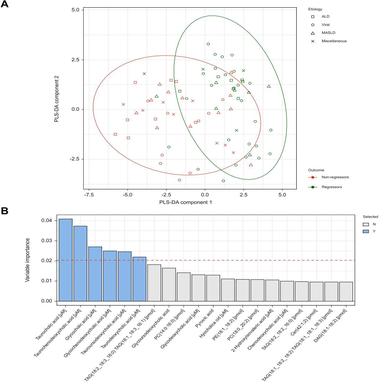
PLS-DA analysis in the discovery cohort. (A) Ranked metabolite importance. Dots represent individual samples colored according to the group of regressors and non-regressors. (B) Distribution of patients based on the two first PLS-DA components. Metabolites with importance greater than the mean importance + 3 standard deviations of all parameters are selected in blue. Accuracy = 79% . CE, cholesterol ester; DAGs, diacylglycerides; PLS-DA, partial least squaresdiscriminant analysis; PC, phosphatidylcholine; P